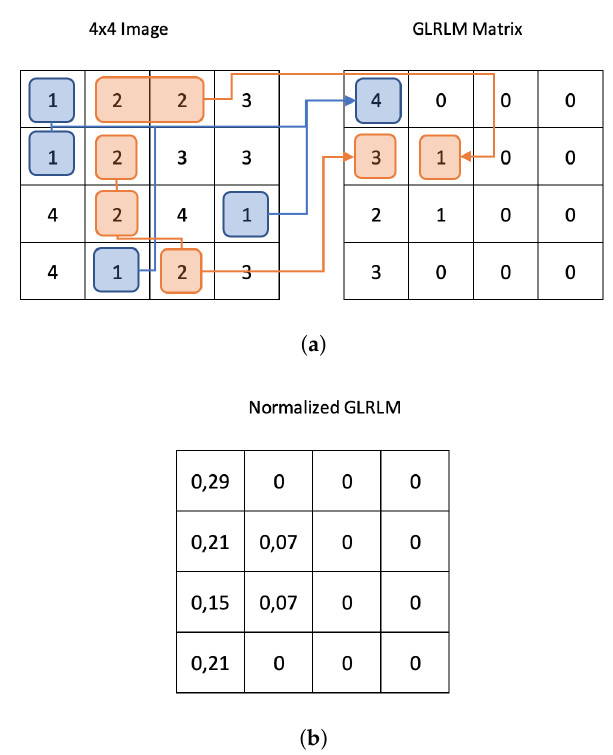
Figure 7. Design of the GLRLM matrix from a 4 × 4 image with 5 gray levels. ( a ) GLRLM matrix being t = 0; ( b ) The GLRLM normalized